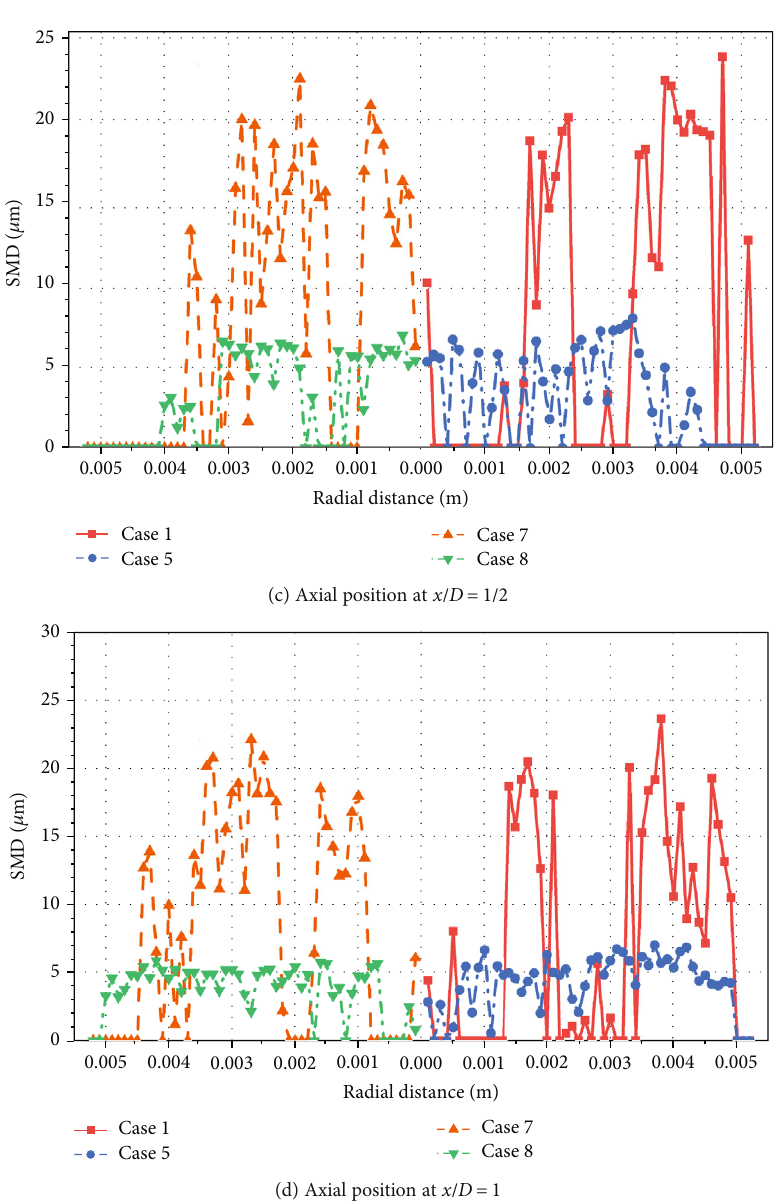
Figure 9: Comparison of the SMD distribution radial direction at the same axial position in di ff erent